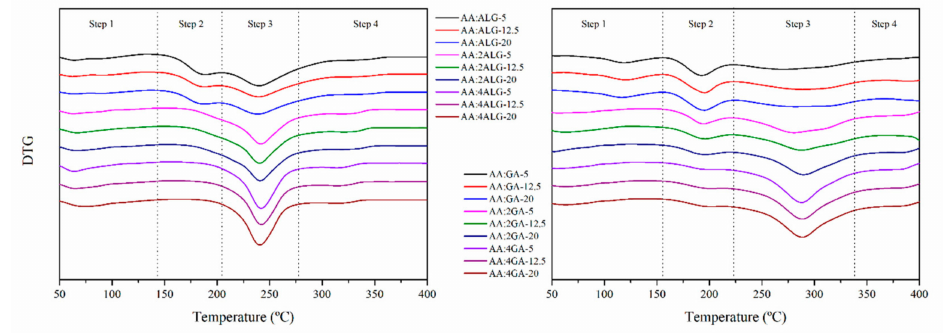
Figure 5. Derivative thermogravimetric curves of the AA:ALG (left) and AA:GA-based (right)